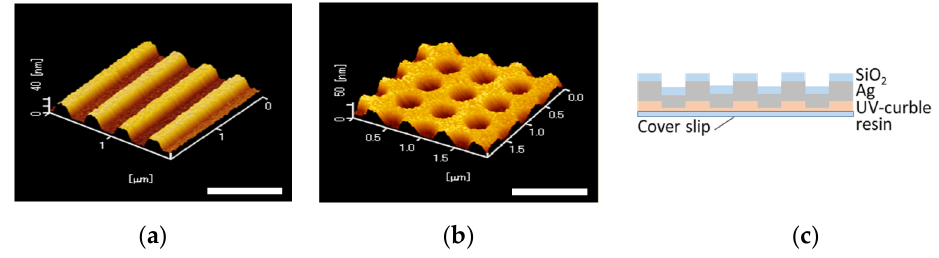
Figure 3. Atomic force microscopy (AFM) image of ( a ) 1D and ( b ) 2D plasmonic chips, and ( c ) the cross section view of the plasmonic chip. Bar corresponds to 1 µm. Table 2. Preparation and fluorescence characteristics of